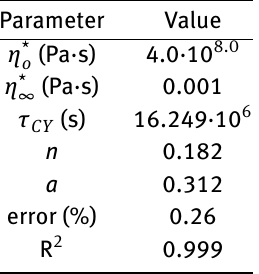
Table 1: Values of the Carreau-Yasuda model that were used in describing the experimental viscosity data of Boufarguine et